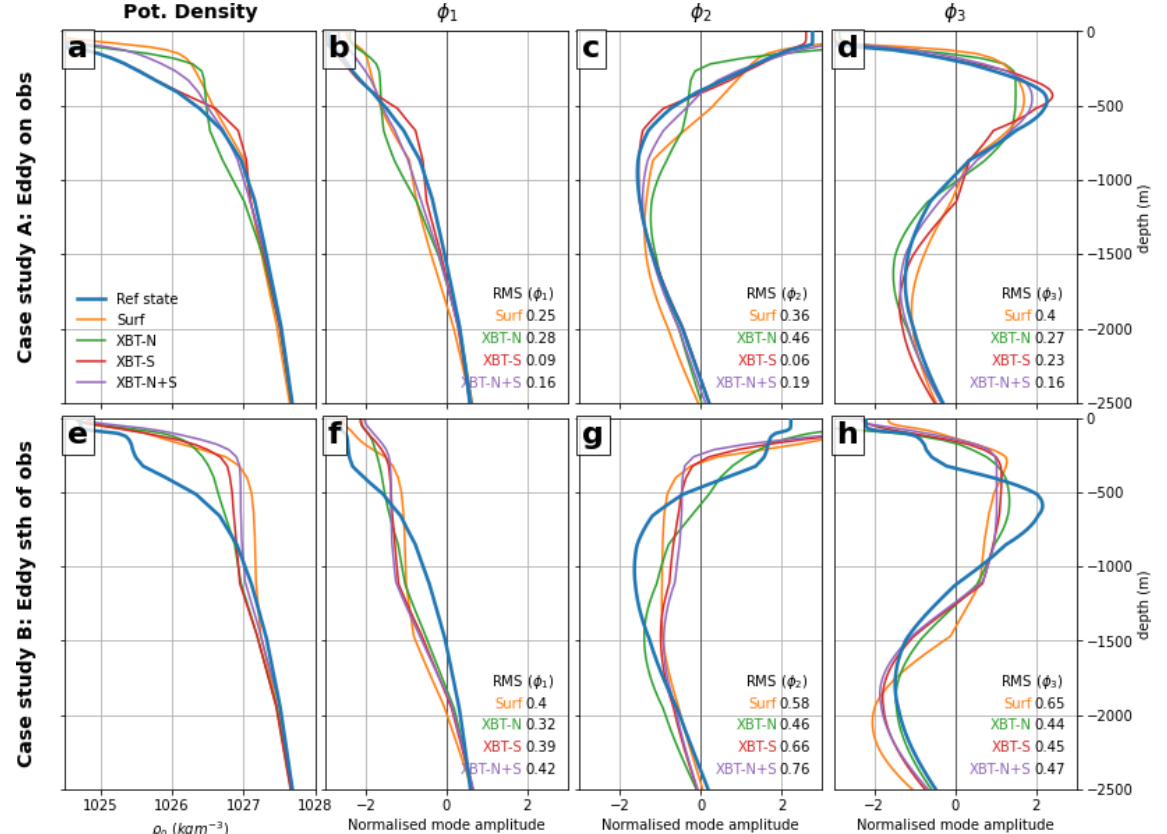
Figure 9. For case study A, the (a) potential density profile is shown for the Ref state and each OSSE, and the amplitude of the baroclinic modes (b) φ 1 , (c) φ 2 , and (d) φ 3 ) are shown for the Ref state and each OSSE. For case study B, the (e) potential density profile and baroclinic modes (f) φ 1 , (g) φ 2 , and (h) φ 3 ) are shown for the Ref state and each OSSE. The barotropic mode ( φ 0 ) is excluded, as by normalisation it has unity value at all depths. Potential densities are referenced to surface pressure. In panels (b) – (d) and (f) – (h) , we show the rms difference of the OSSE mode shape compared to that of the Ref state. Note that the vertical axis has been limited to the top